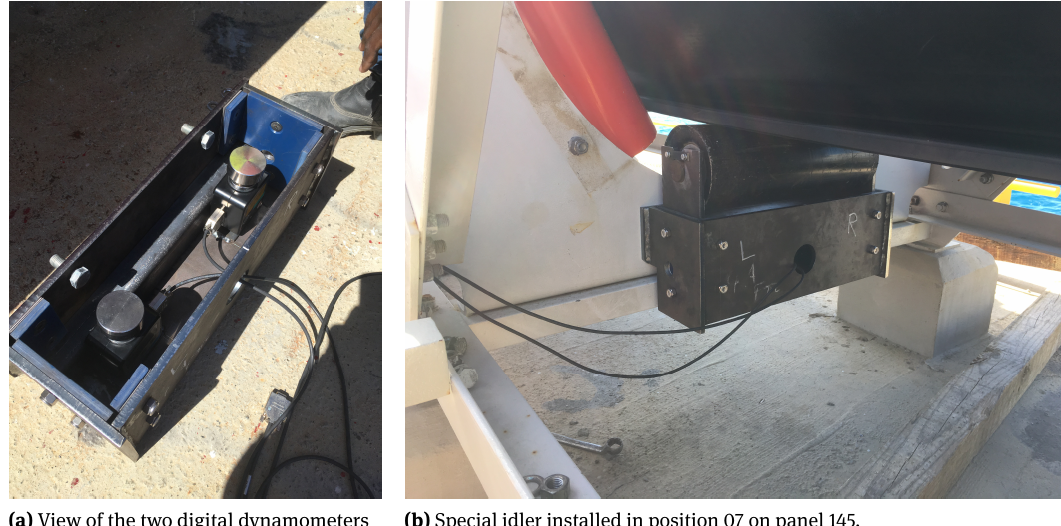
Figure 3: Special idler constructed for measuring force excreted onto the roller.